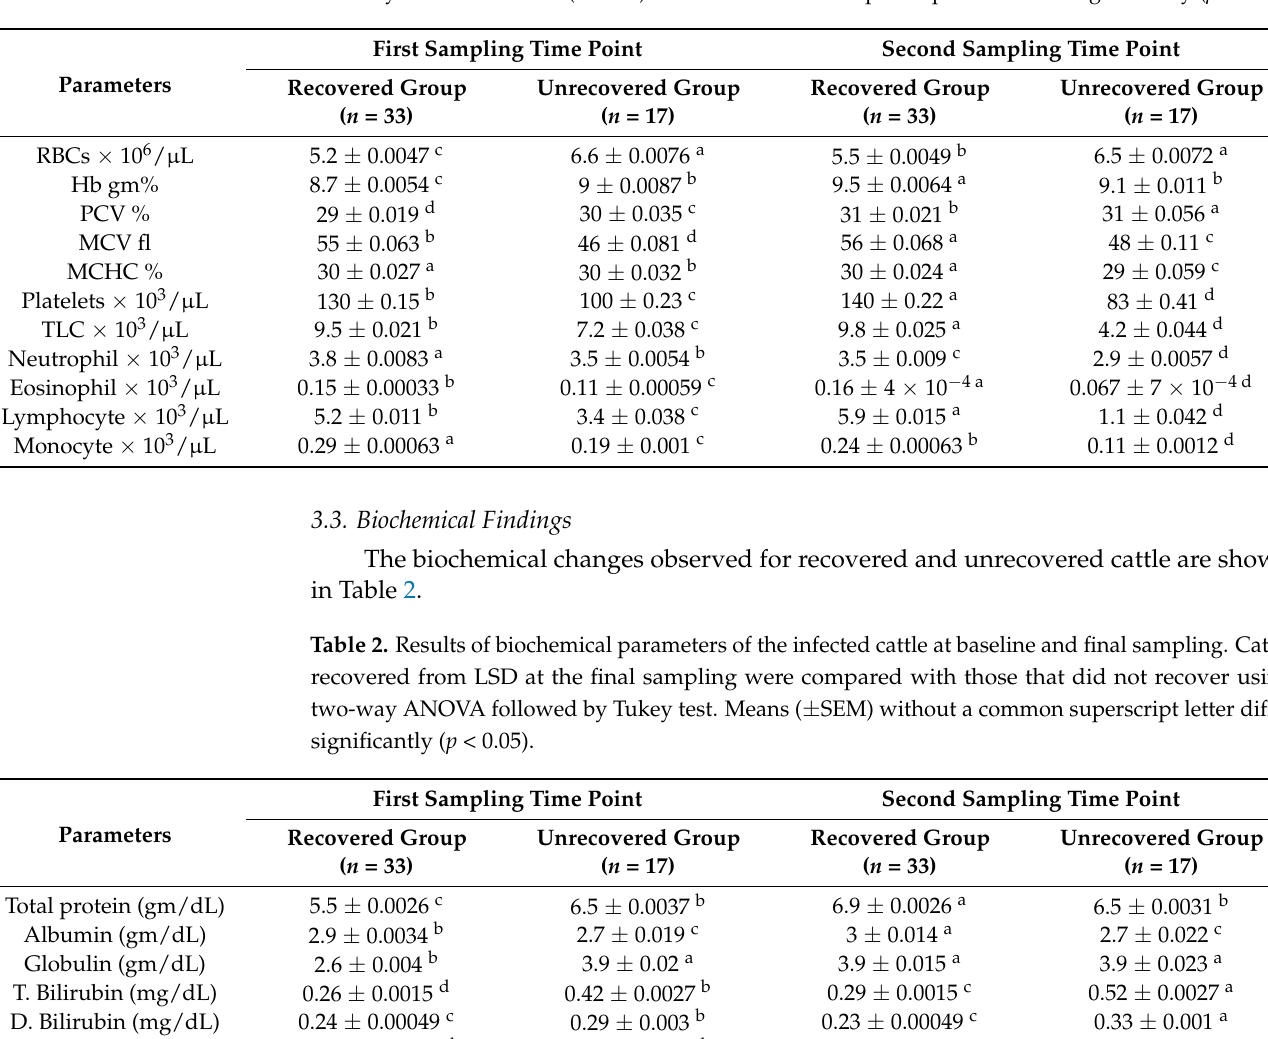
Table 1. Values of hematological parameters of the infected cattle at baseline and final sampling. Cattle recovered from LSD at the final sampling were compared with those that did not recover using two-way ANOVA. Means ( ± SEM) without a common superscript letter differ significantly ( p < 0.05).